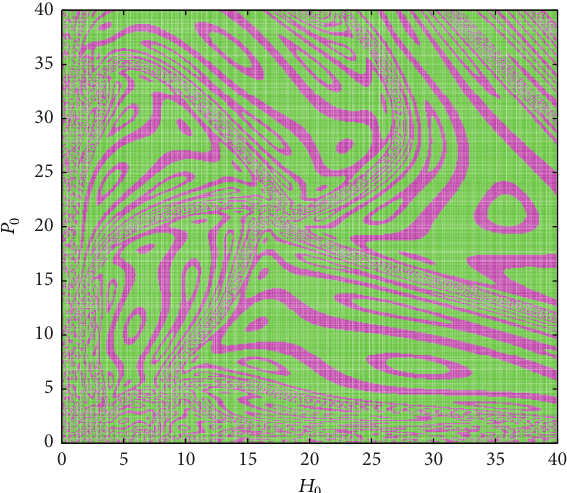
Figure 8: The basins of attraction of model (4) for two attractors shown in Figure 6. The parameter values are as follows: 𝑇 = 10 , 𝑇 ℎ = 0.5 , 𝐾 = 50 , 𝛿 = 0.3 , 𝛾 = 1 , 𝛼 = 0.01 , 𝜃 = 0 , 𝑞 = 0 , and 𝑟 = 2.99 .